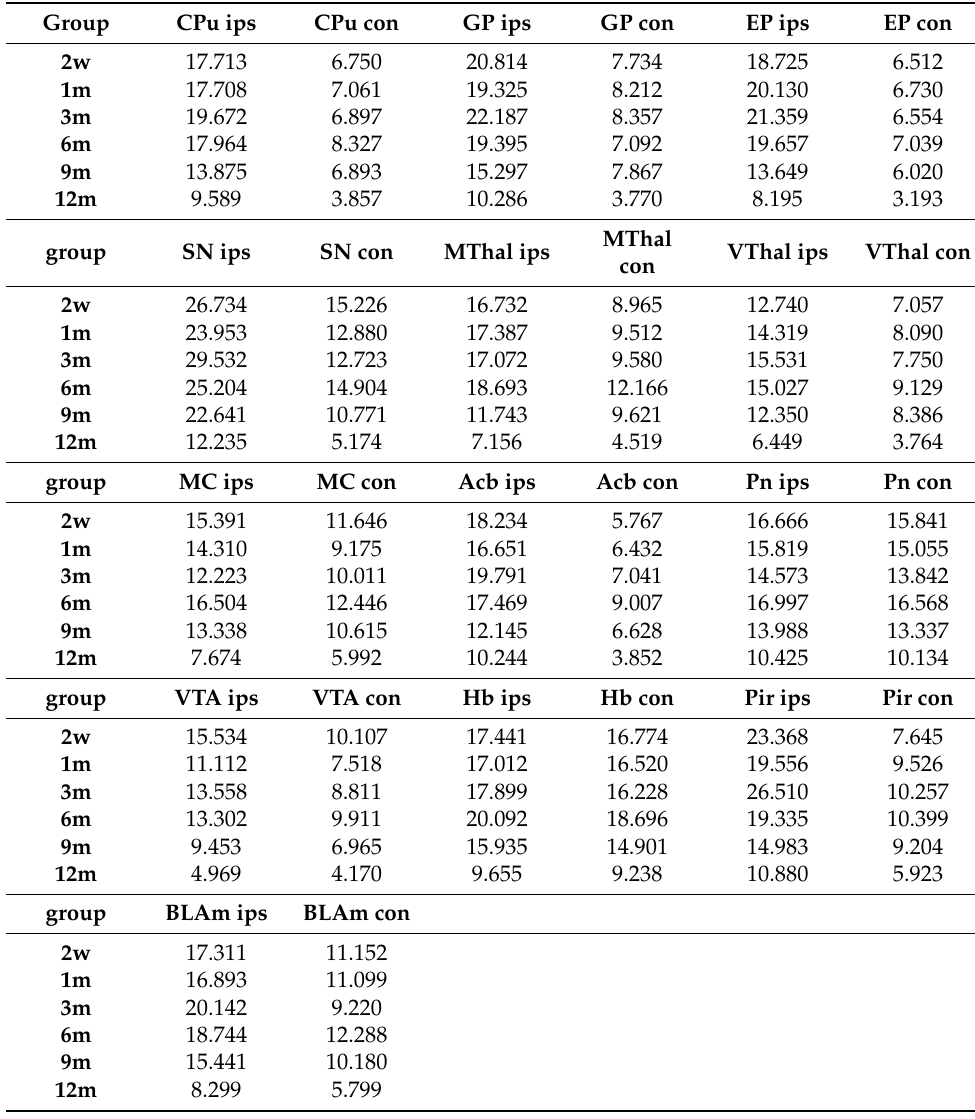
Table 1. The table summarizes the mean optical densities in % of the structures studied for all experi- mental animal groups: 100% stands for complete opacity and 0% for complete light transmission of the specimen. For clarity, the table has been divided into four parts. The addition “ips” to the column name stands for ipsilateral (region to the injection side) and the addition “con” for contralateral (to the injection side). CPu: caudate-putamen complex, GP: globus pallidus, EP: entopeduncular